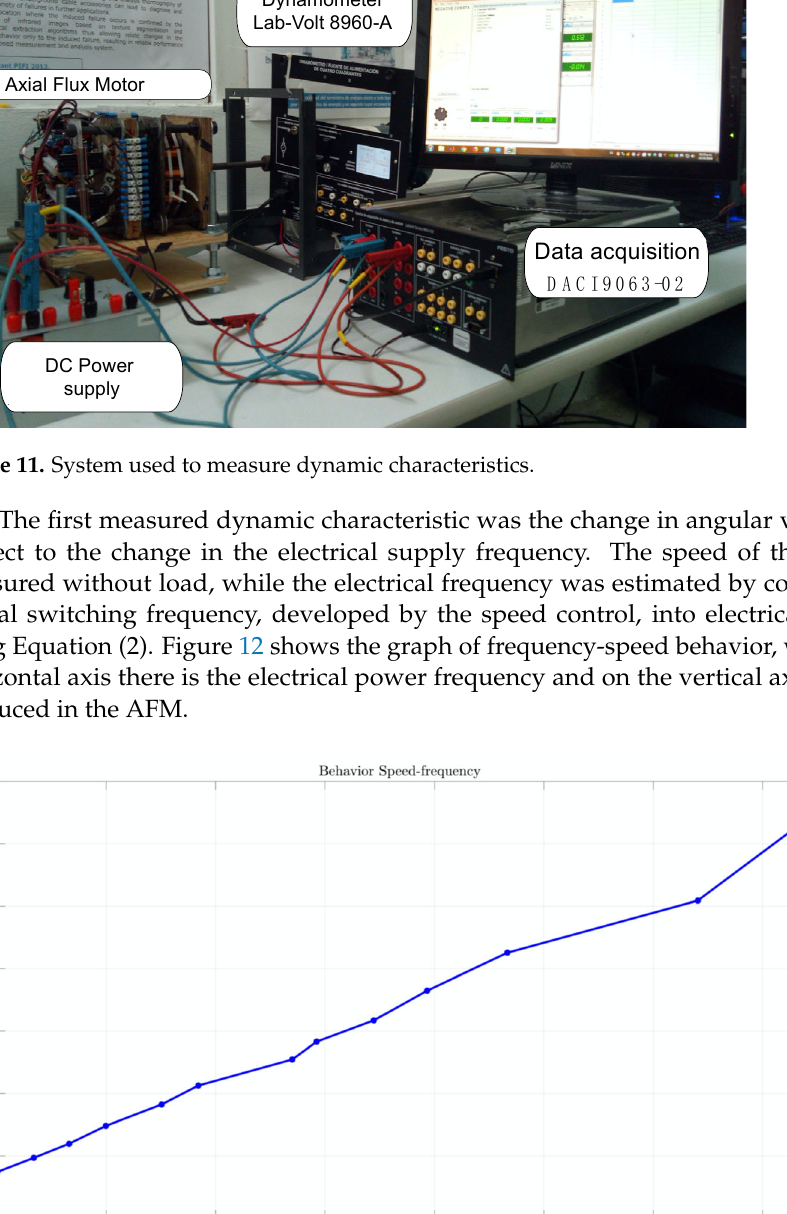
10 of 13 Table 4. AFMPM general characteristics. Parameter